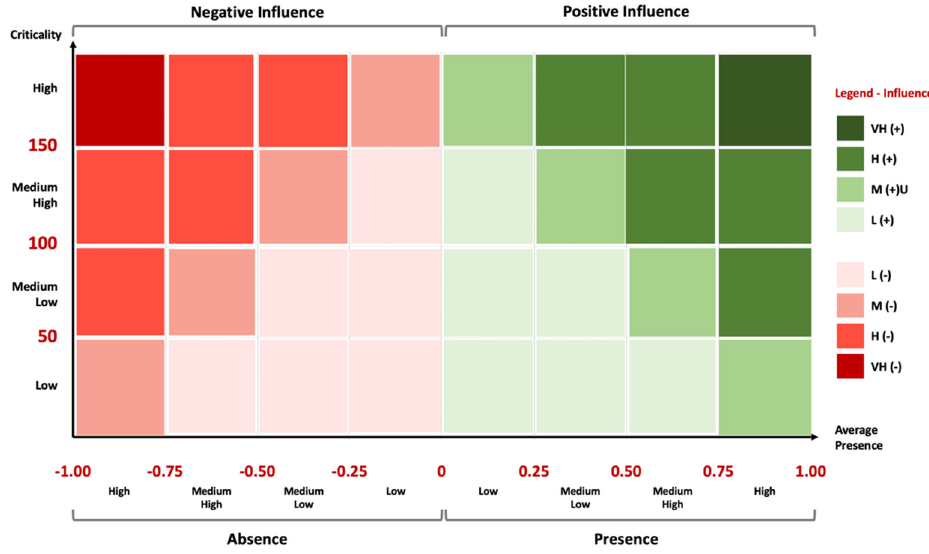
Figure 8. Matrix of Influence. Source: the authors.